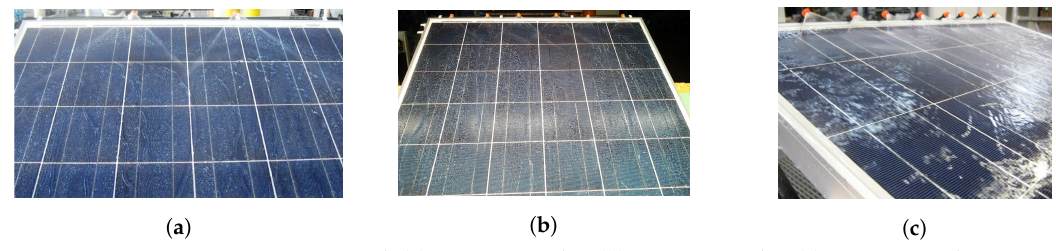
Figure 13. Spraying test with ( a ) 2 water nozzles, ( b ) 6 water nozzles, ( c ) 9 water nozzles.